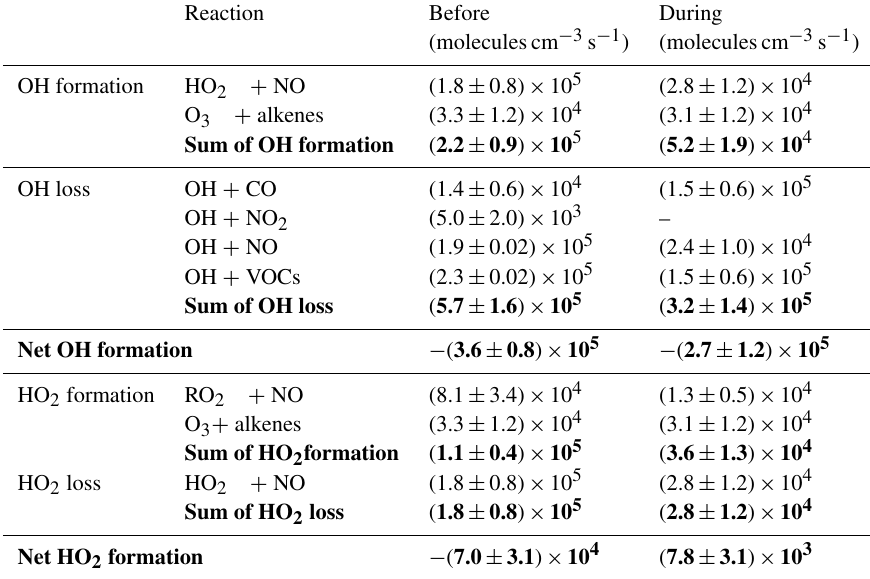
Table 8. Contributions of LPG-fueled vehicle exhaust to the formation and loss of OH and HO 2 before and during the program. The bold fonts demonstrate the sum of OH/HO2 formation/loss rates or the net formation rate of OH / HO 2